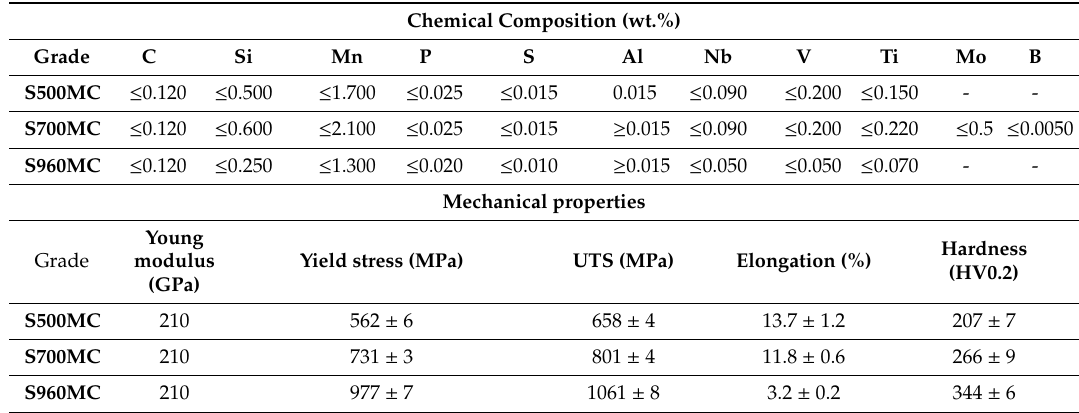
Table 1. Chemical composition and mechanical properties of HSLA